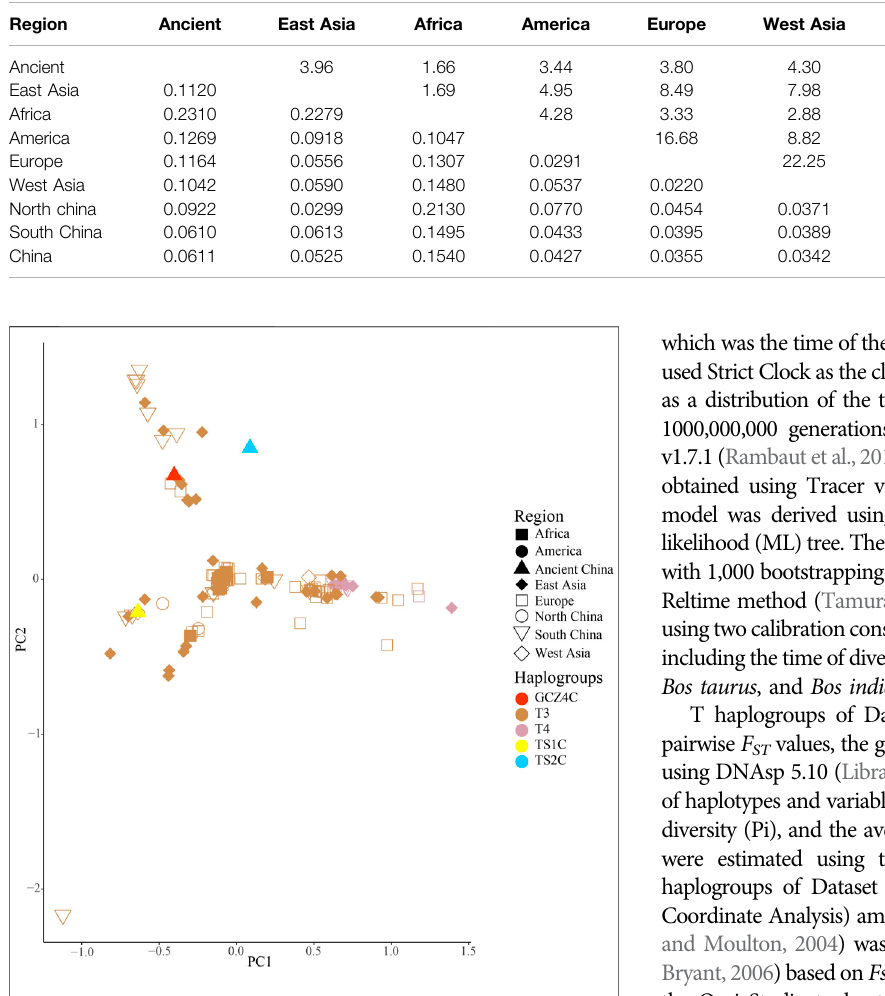
FIGURE 3 | PCA analysis of ancient samples and T3/T4 species haplogroup Bos .